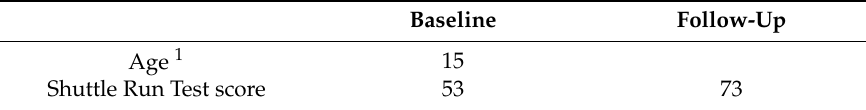
Table A1. Number of participants with imputed values per